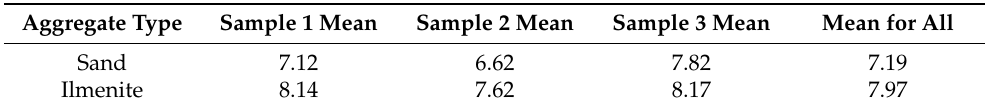
Table 2. The ratio between surface and volumetric resistivity.